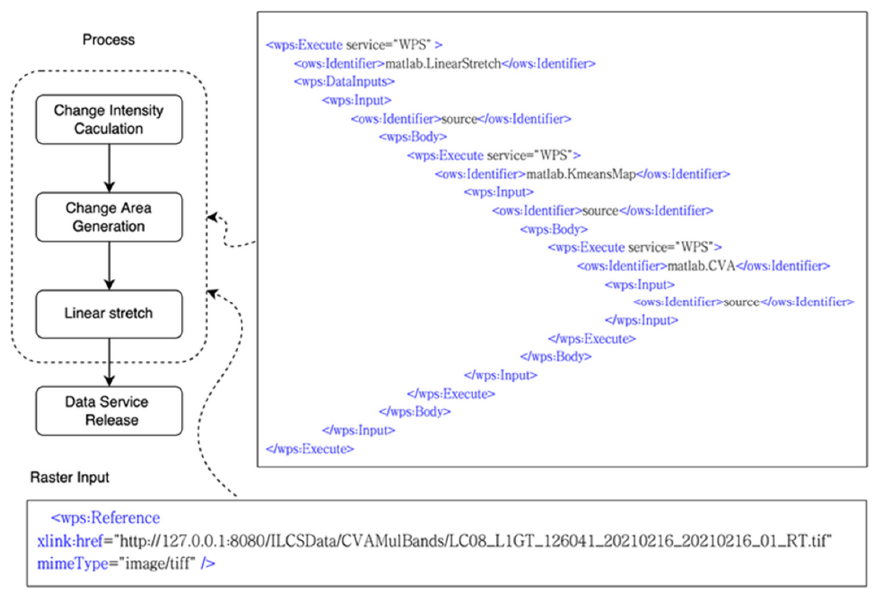
Figure 9. XML description of the service chain template.